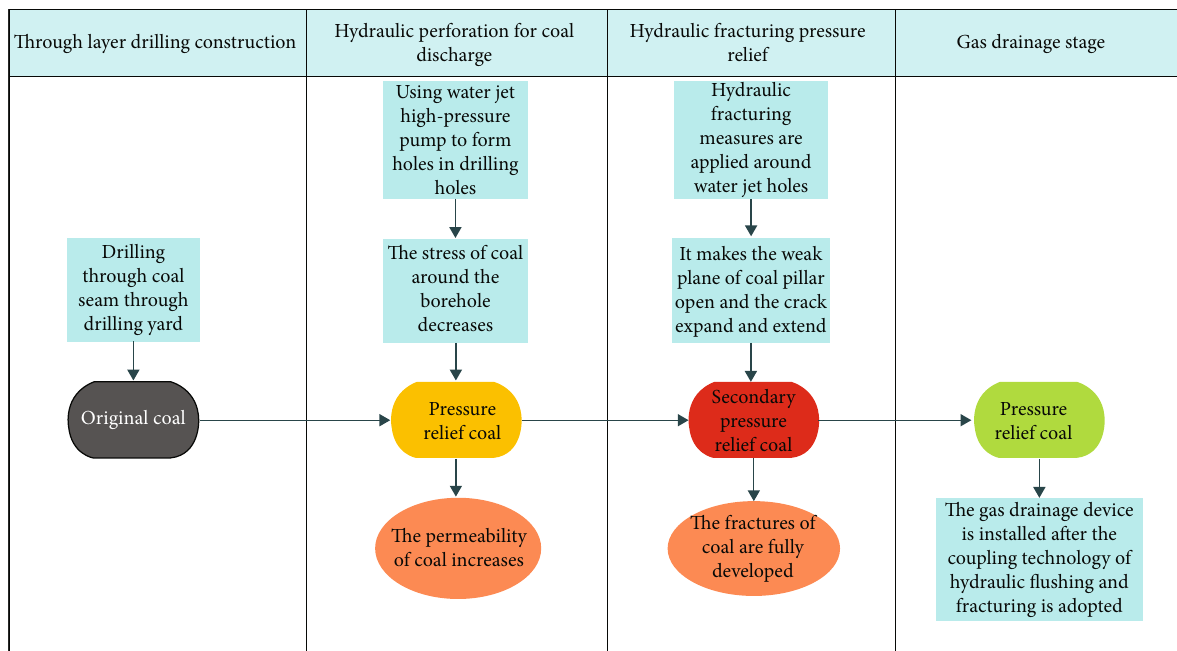
Figure 3: Working diagram of hydraulic fl ushing coal drainage and fracturing coupling fracturing and permeability enhancement technology.